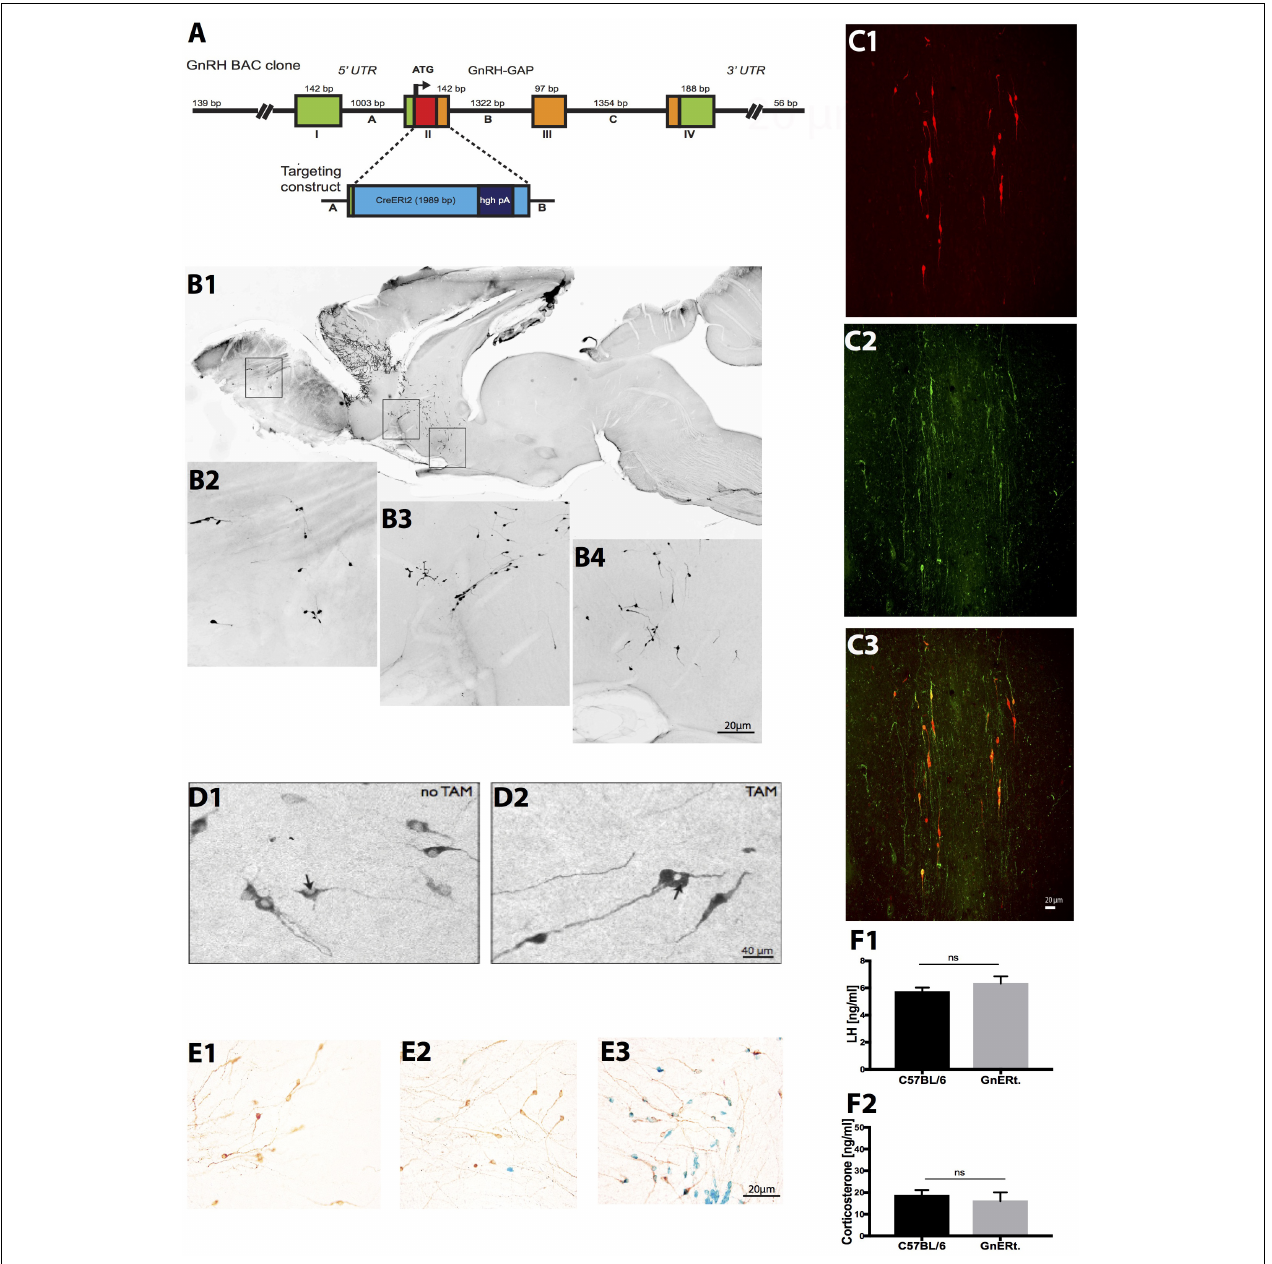
FIGURE 1 | Generation and characterization of GnRH-CreERt2 BAC mice. (A) Schema of the GnRH-CreERt2 targeting vector. Bacterial artificial chromosome (BAC) containing the GnRH promoter driving the expression of the fusion proteins of modified estrogen receptor alpha ligand binding protein and improved Cre recombinase (CreERt2). The four exons (I–IV) of the GnRH gene are presented as boxes, the three introns (A–C) as lines in between. GAP, GnRH-associated peptide; hgh pA, polyadenylation sequence of the human growth hormone; UTR, untranslated region. (B) Immunocytochemical analysis of a sagittal brain slice from a GnRH-CreERt2 mouse (B1) shows that Cre expression resembles the pattern of GnRH expression in the olfactory bulb (B2) , terminal nerve (B3) , and preoptic area (B4) . (C) Colocalization of Cre and GnRH. Coronal sections of GnRH-CreERt2 mouse brain were stained for Cre (visualized using Cy3, red; C1 ) and GnRH (visualized using FITC, green; C2 ). The overlay of both channels shows that virtually all GnRH neurons express Cre (C3) . (D) Tamoxifen-dependent translocation of Cre recombinase from cytoplasm to nucleus. Sections were stained for CreERt2 (visualized using DAB). In untreated GnRH-CreERt2 mice, Cre resides in the cytoplasm (D1) , while injection of tamoxifen induces translocation of Cre into the nucleus ( D2 , indicated by arrow). (E) Tamoxifen-induced Cre recombination in GnRH neurons, assessed using combined X-gal staining for β -galactosidase activity and immunostaining for GnRH. Vehicle (oil) injection did not induce β -galactosidase activity in GnRH neurons ( E1 , brown color). A single tamoxifen injection resulted in the appearance of β -galactosidase activity (blue color) in single GnRH neurons (E2) . Ten injections of TAM induced β -galactosidase activity exclusively in GnRH neurons, and in virtually all GnRH neurons (E3) . (F) Plasma concentrations of LH (F1) and corticosterone (CS; F2 ). LH and CS concentrations did not differ between C57BL/6 WT ( n = 14) and GnRH-CreERt2 (GnERt) mice ( n = 5). Results are expressed as mean ± SEM; unpaired t -test, p > 0.05; ns, no significant statistical difference.